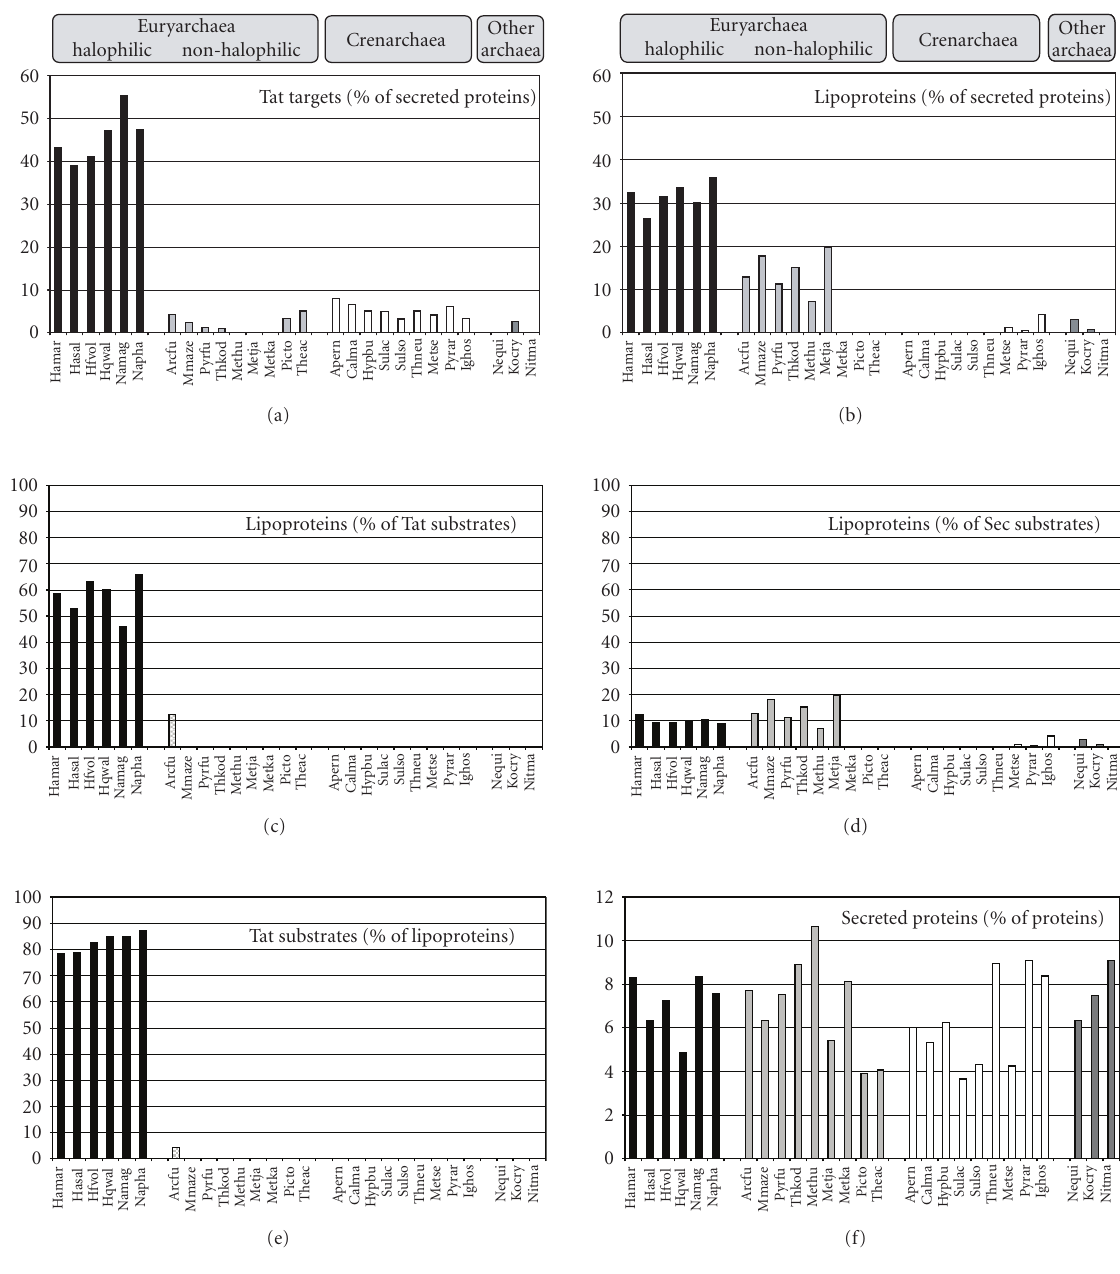
Figure 5: Only haloarchaeal Tat substrates are predicted to be predominantly lipoproteins. The predicted relative proportions are shown for several types of secreted proteins for halophilic and non-halophilic euryarchaeal species as well as crenarchaeal species and three species belonging to other archaeal phyla. (a) The percentage of secreted proteins that are Tat substrates. (b) The percentage of secreted proteins that are lipoproteins. (c) The percentage of Tat substrates that are lipoproteins. (d) The percentage of Sec substrates that are lipoproteins. (e) The percentage of lipoproteins that are secreted via the Tat pathway. (f) The percentage of proteins that are secreted (predicted Tat and Sec substrates with SPase I or SPase II cleavae sites). Raw data are available in Supplementary Table 4. Organisms are abbreviated as follows: haloarchaea (Hamar: Haloarcula marismortui ; Hasal: Halobacterium salinarum ; Hfvol: Haloferax volcanii ;